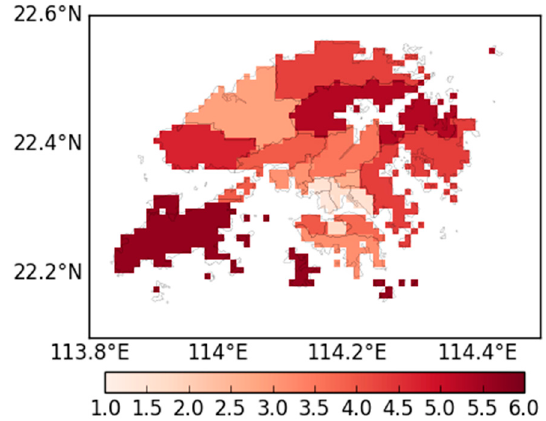
Figure 8. The BRT for exposure in different districts of Hong Kong.